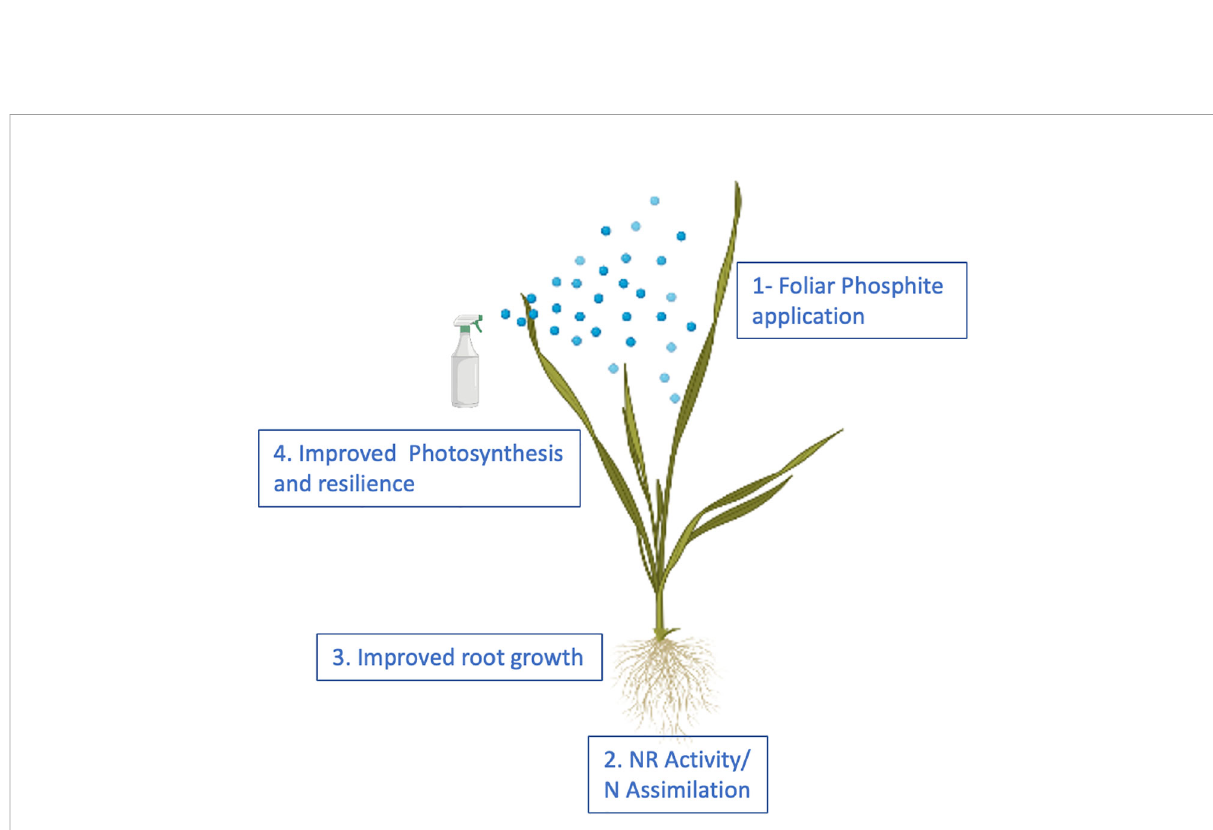
FIGURE 8 Proposed model for phosphite action. The model provides a temporal framework for impact of phosphite on root growth. Phosphite treatment results in the induction of NAS gene expression and Fe homeostasis to regulate NR activity and root